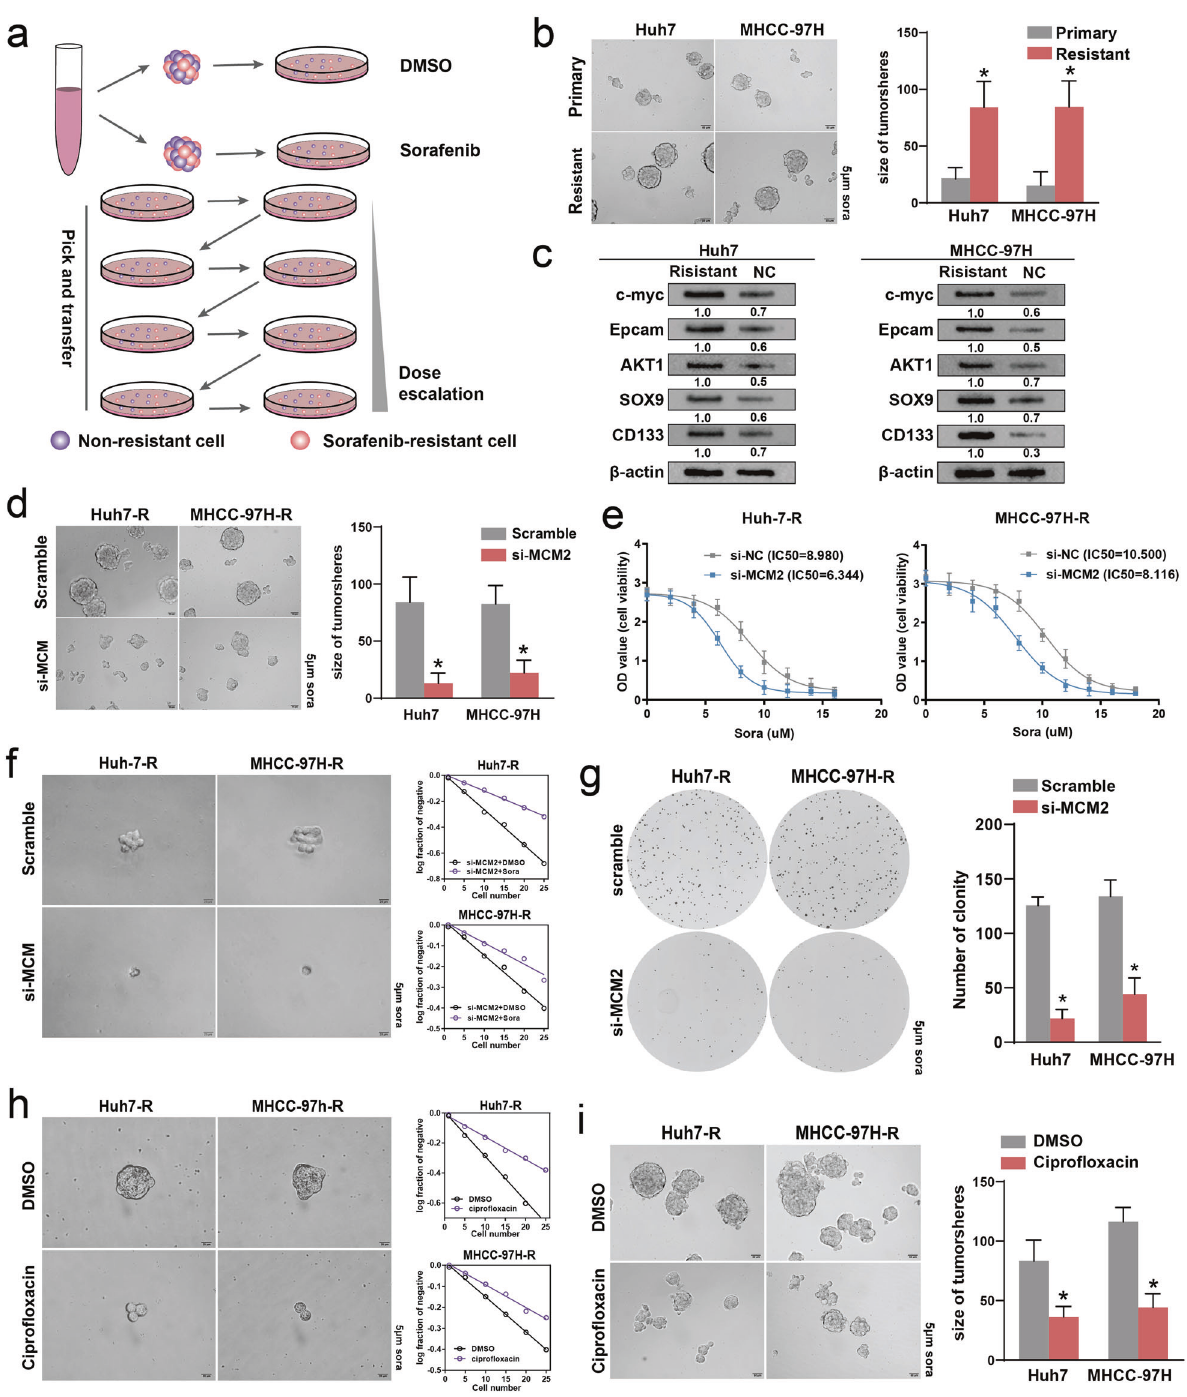
Fig. 6 Down-regulation of MCM2 inhibit the resistance of HCC cells to Sorafenib. a Diagram of the construction of sorafenib-resistant cell lines; b Representative images of tumor-sphere for sorafenib-resistant and non-resistant groups of the indicated cells and corresponding histogram, under 5 μ M sorafenib intervention. c Representative images of tumor-sphere for si-MCM2 and scramble groups of the indicated cells and corresponding histogram, under 5 μ M sorafenib intervention. d Viability of si-MCM2 and scramble groups of the indicated cells under multiple concentrations of sorafenib intervention. e The immunoblotting for c-myc, Epcam, AKT1, SOX9 and CD133 expression in the si- MCM2 and scramble groups of the indicated sorafenib-resistant cells, determined by Western Blot assay; f Representative images of tumor- spheres formation in the limiting dilution assays of the indicated sorafenib-resistant cells treated with sorafenib (5 μ M) and the log-dose slope of the si-MCM2 and scramble groups. g Representative images of colony in the si-MCM2 and scramble groups of indicated sorafenib-resistant cells treated with sorafenib (5 μ M) and corresponding histogram. h Representative images of tumor-spheres formation in the limiting dilution assays of the indicated sorafenib-resistant cells treated with sorafenib (5 μ M) and the log-dose slope of the cipro fl oxacin (MCM2 inhibitor) and solvent groups. i Representative images of tumor-spheres in the cipro fl oxacin (MCM2 inhibitor) and solvent groups of indicated sorafenib- resistant cells treated with sorafenib (5 μ M) and corresponding histogram. Data are shown as the mean ± SD from independent experiments. * P < 0.05. sora,